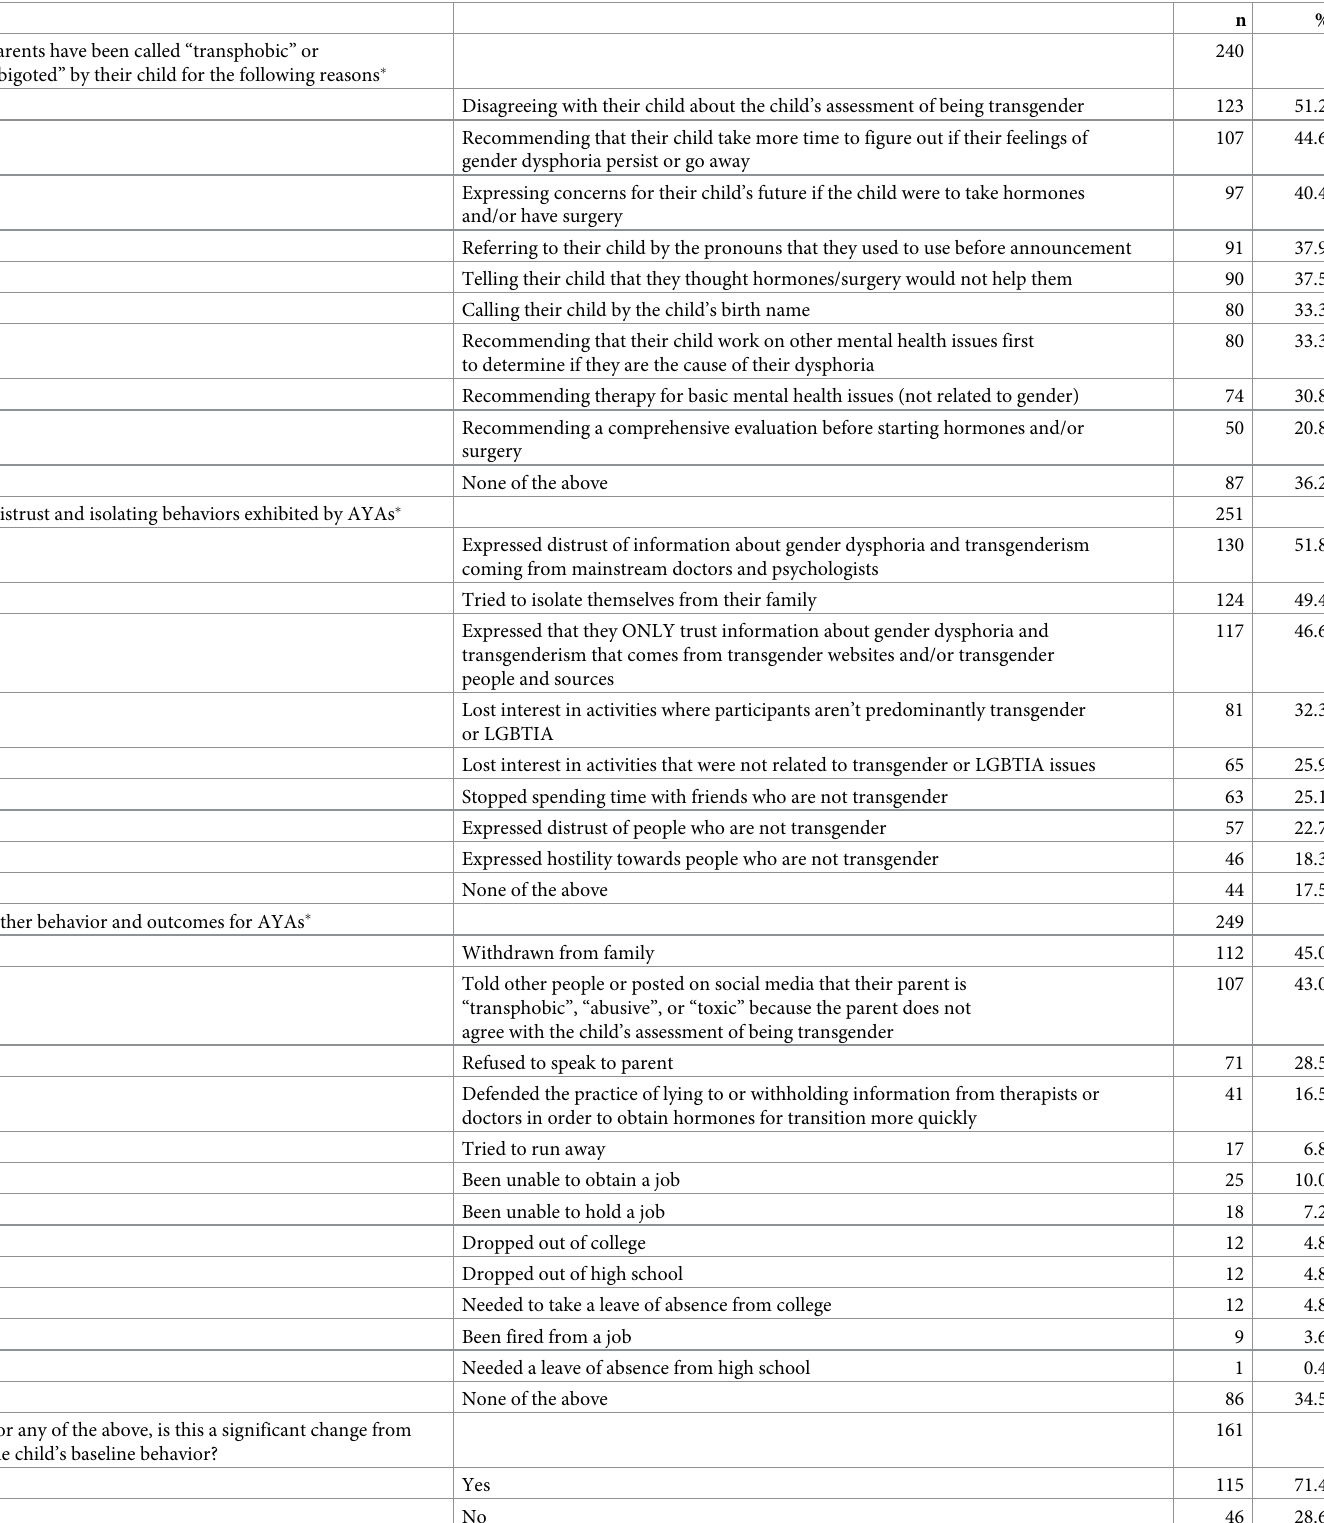
Table 10. Additional behaviors.